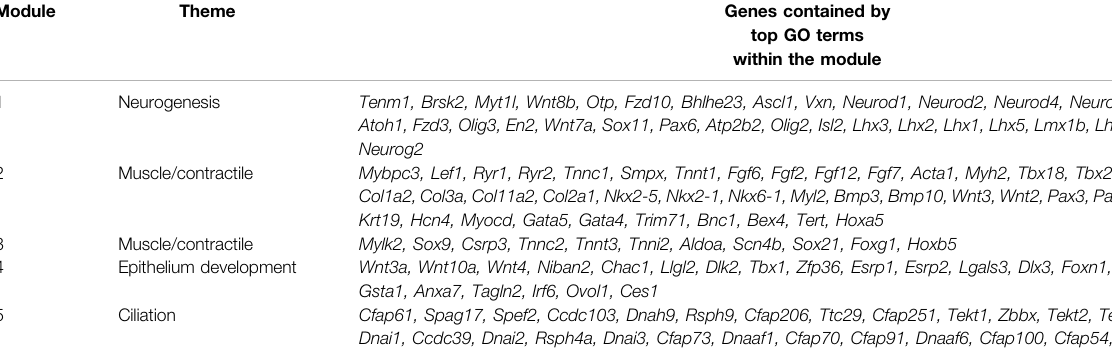
TABLE 1 | Select DEGs from top GO terms contained by the gene modules shared across the larynx, esophagus, and trachea from embryonic timepoints E10.5 – E18.5 shown in Figure 1B .